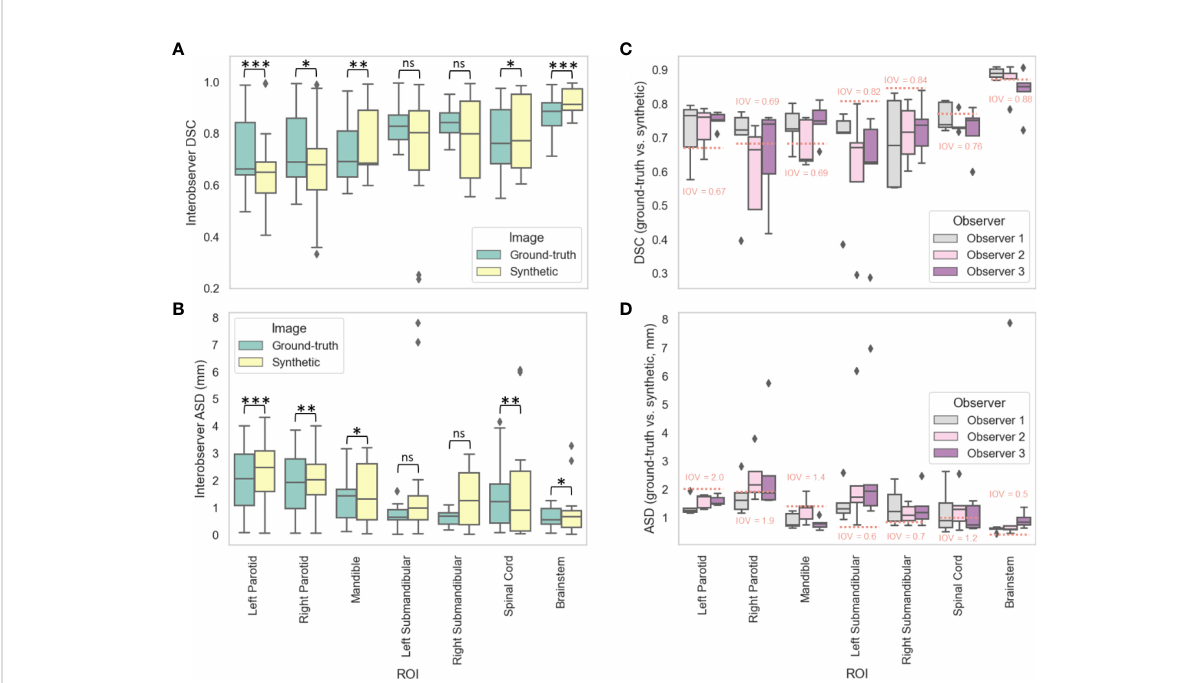
FIGURE 4 Manual segmentation results. For three clinician observers, manually segmented organs at risk (left parotid gland, right parotid gland, mandible, left submandibular gland, right submandibular gland, spinal cord, brainstem) were generated on ground-truth or synthetic 6-minute images; interobserver variability (IOV) values were calculated pairwise between each observer for ground-truth (green) and synthetic (yellow) images using the (A) Dice similarity coef fi cient (DSC) and (B) average surface distance (ASD). Segmentations generated on ground-truth and synthetic images were then compared for each observer using the (C) DSC and (D) ASD. Stars above plot indicate paired two one-sided t-tests (equivalence test) level of signi fi cance: ns: p > 0.05; *: 0.005 < p <= 0.05; **: 0.0005 < p <= 0.005; ***: p<= 0.0005. Red dotted lines correspond to median IOV metric values derived from clinical experts on ground-truth 6-minute images in this